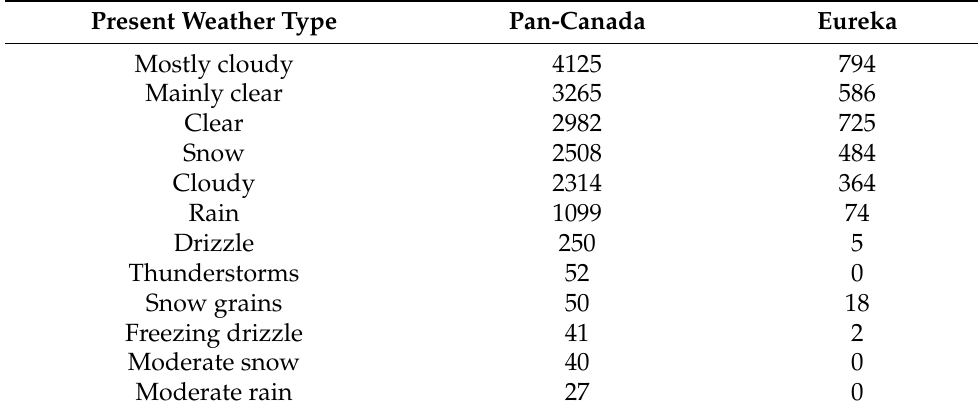
Table 4. Table showing the frequency of present weather types (sample size) considered in this study obtained after matching CloudSat and ECCC weather data at Eureka and